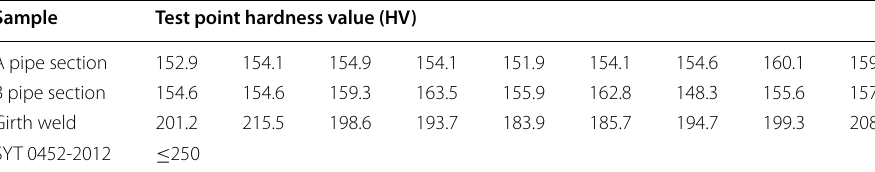
Table 8 Hardness test results